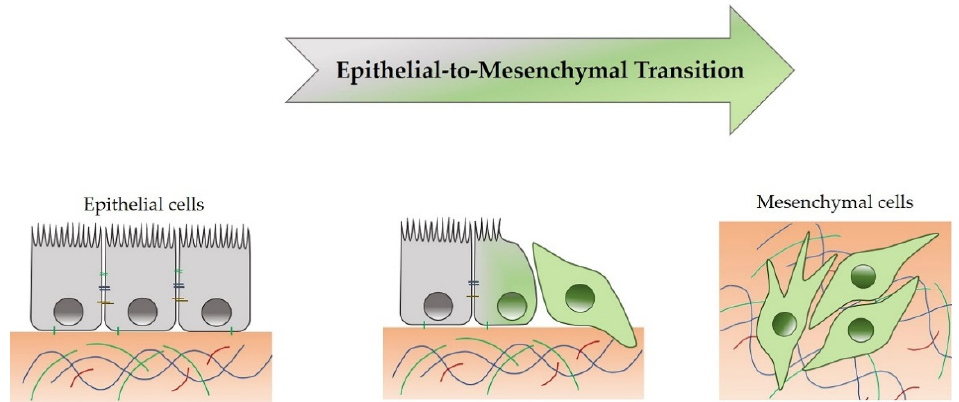
Figure 1. Transition from epithelial cell toward a mesenchymal phenotype.